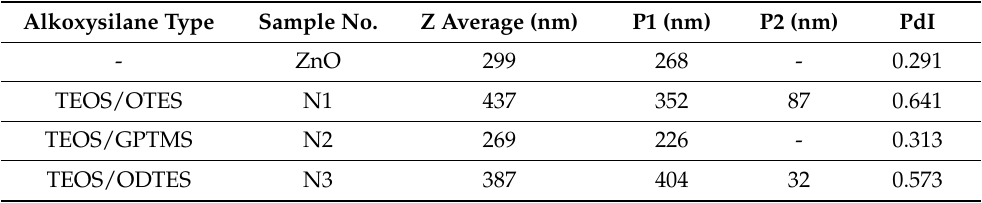
Table 2. Average sizes of main population (P1), second population (P2) of unmodified ZnO and modified ZnO-NPs (nanoparticles) with the specified types of alkoxysilanes ((TEOS/OTES), (TEOS/GPTMS), (TEOS/ODTES)) and the polydispersity index (PdI). Alkoxysilane Type Sample